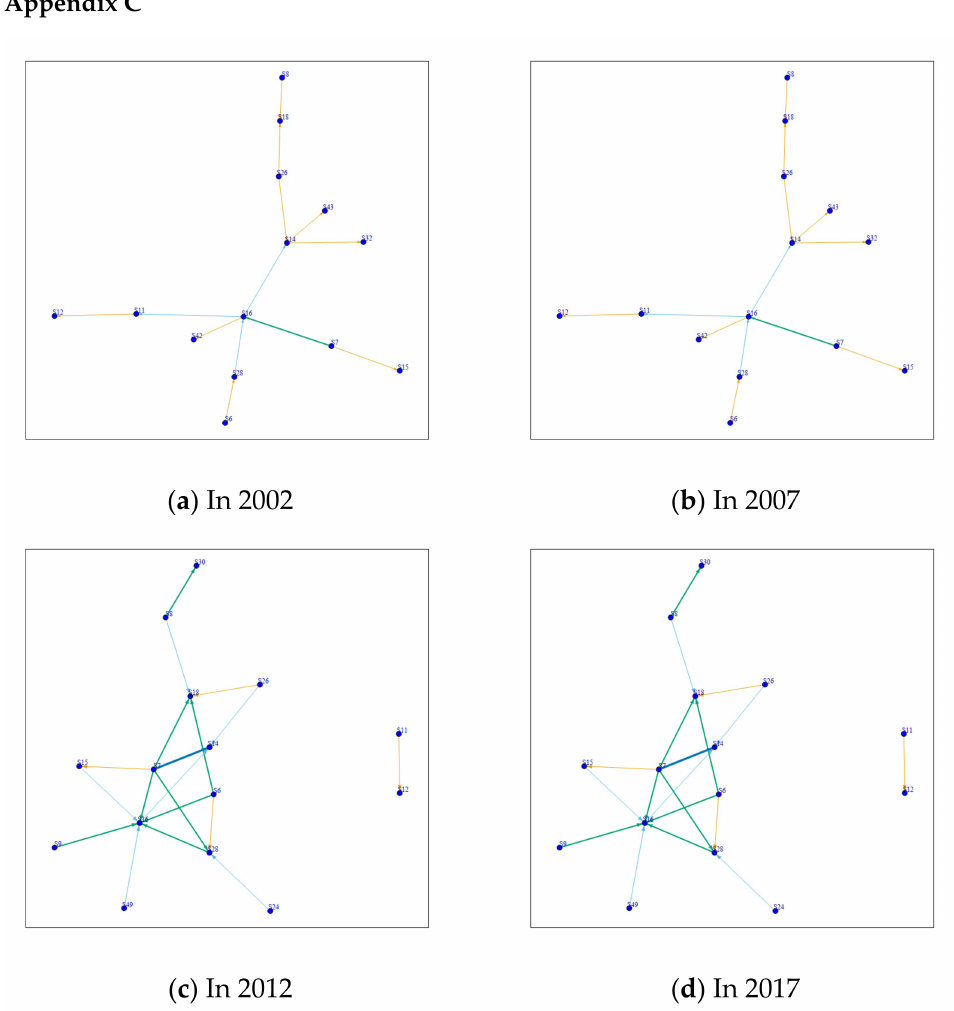
Figure A1. Wastewater propagation chains that obtained by the traditional model [7]. Each vertex in sub-figures represents a sector, e.g., S43 in sub-figure (a) corresponds to Culture, Sports and Entertainment in Appendix B. The orange, blue and green edges mean that their APL value is 1, 2 and 3,